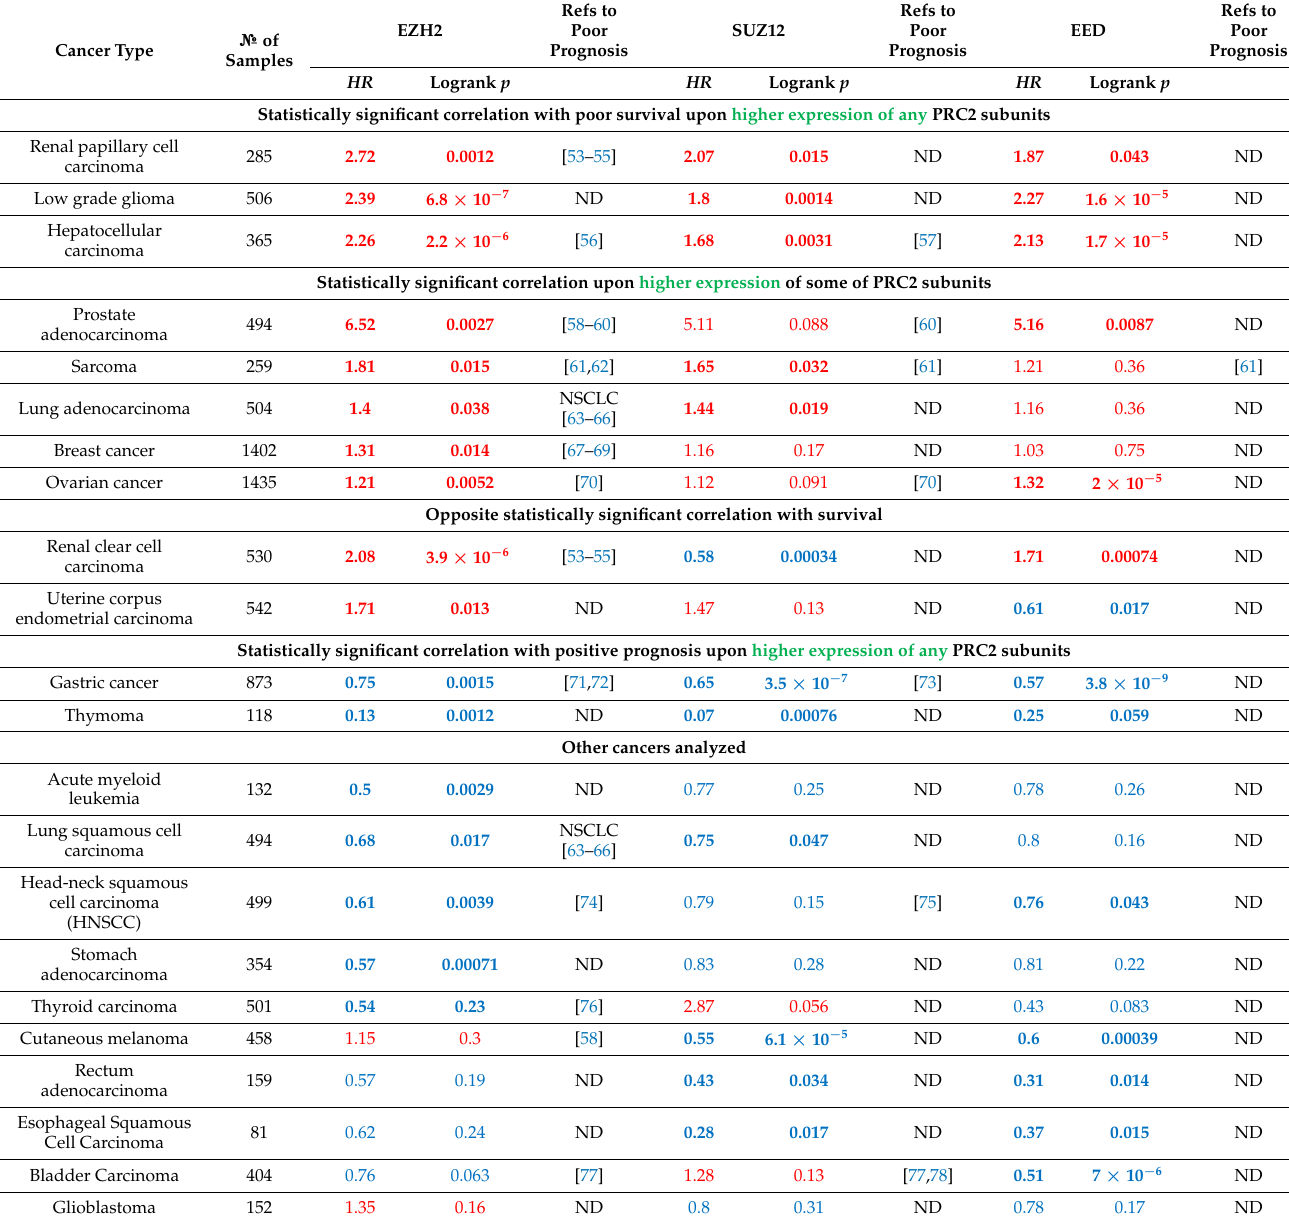
Table 1. Correlations of EZH2 , SUZ12 and EED gene expression with overall survival in different tumor types. The hazard ratio (HR) and p- values are shown in red when higher gene expression is correlated with a shorter survival, and in blue in case of a longer survival. logrank p < 0.05 are boldfaced. The “Refs to poor prognosis” columns indicate references to previous studies showing the correlation with poor survival of the respective PRC2